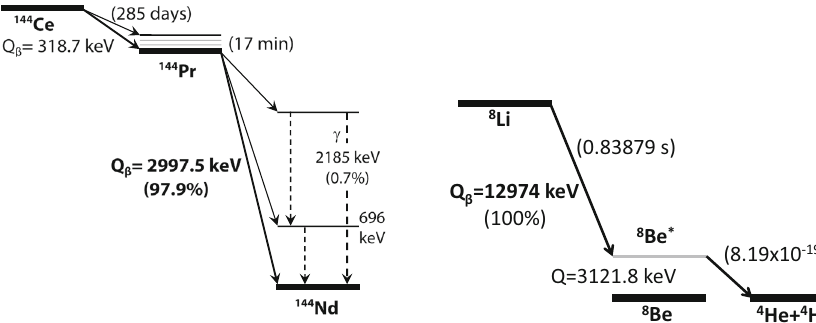
Fig. 1 The decay scheme of isotopes chain 144 Ce − 144